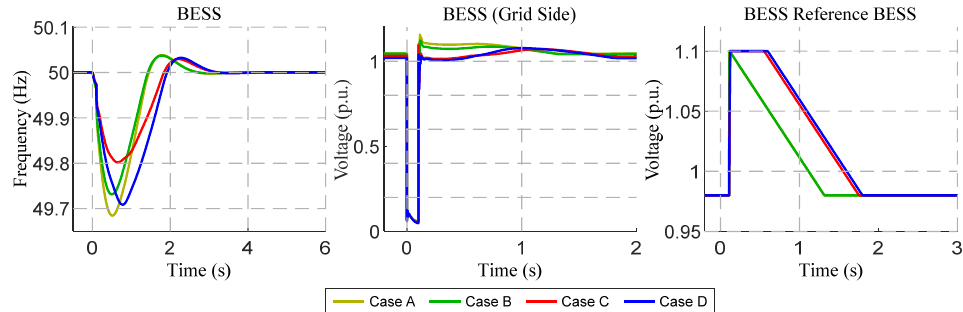
Figure 32. Small ( left ) and large ( right ) industrial motors’ speeds and terminal voltages. Figure 31. BESS power converter synthetic frequency and reference and terminal voltages: influ- ence of different shares of IM loads.